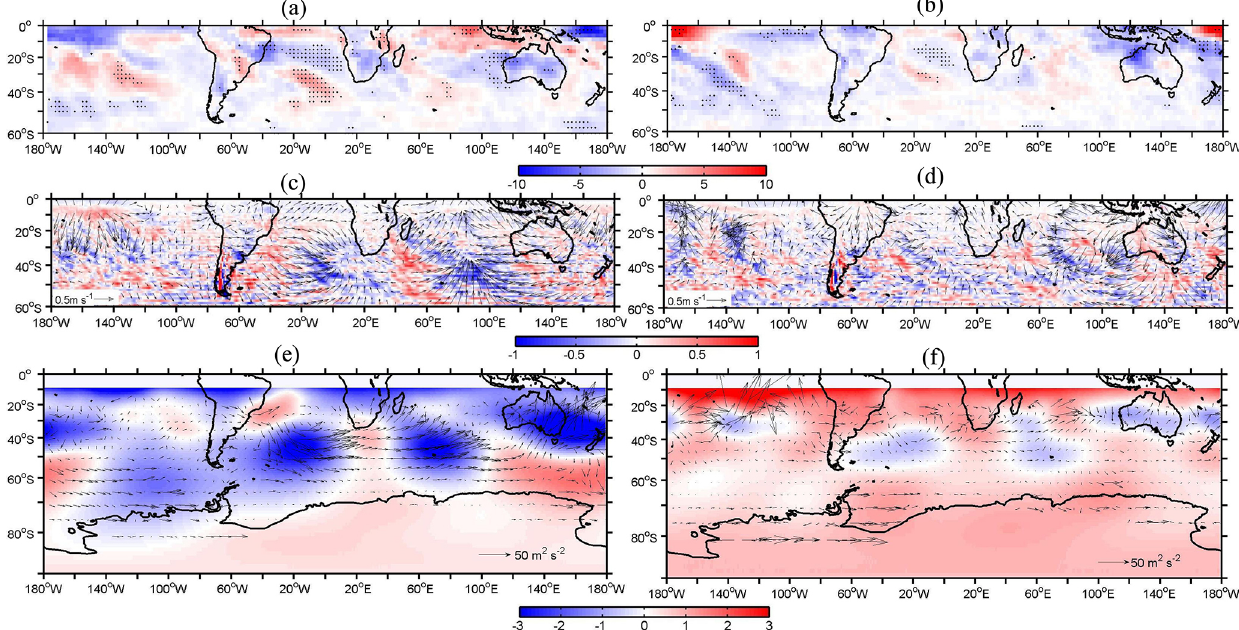
Figure 4. Regression maps of (a, b) the anomalous outgoing long-wave radiation (OLR) (Wm − 2 ) at the top of the atmosphere, (c, d) the Rossby wave sources (RWSs) (10 − 10 s − 2 ) and 200hPa divergent wind (vectors), and (e, f) the wave activity flux (WAF) (vector) and streamfunction (m 2 s − 1 ) on the summertime SAOD index over the periods of (a, c, e) 1979–1999 and (b, d, f) 2000–2020.